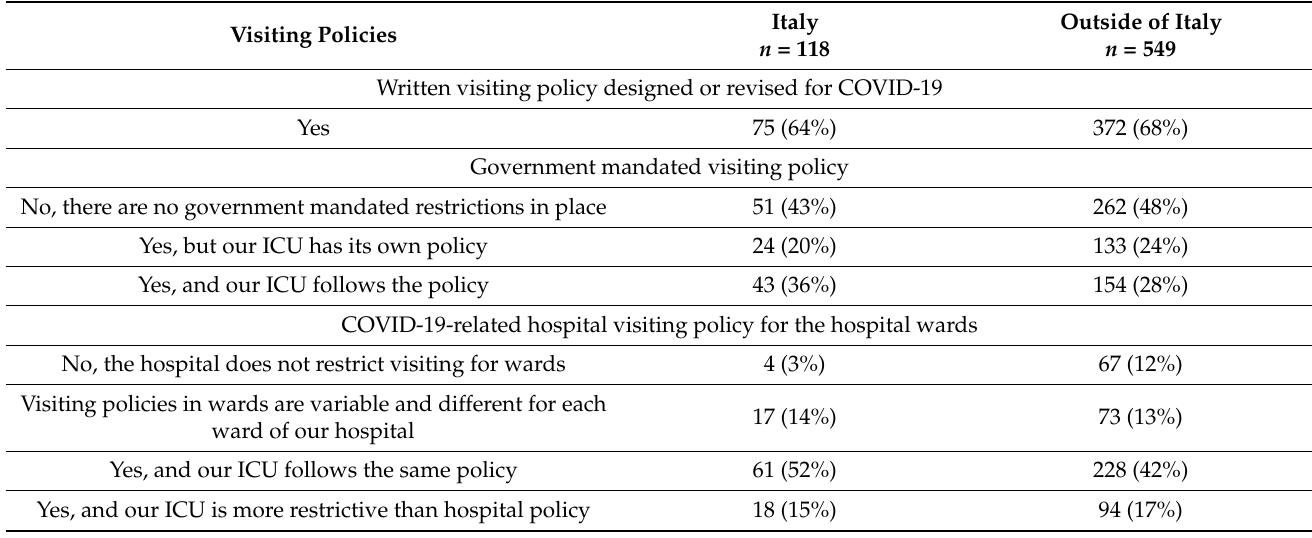
Table 2. Protocols and policies in respondents’ ICUs in Italy and outside of Italy at the time of the survey. The percentages do not sum to 100% as participants could select multiple